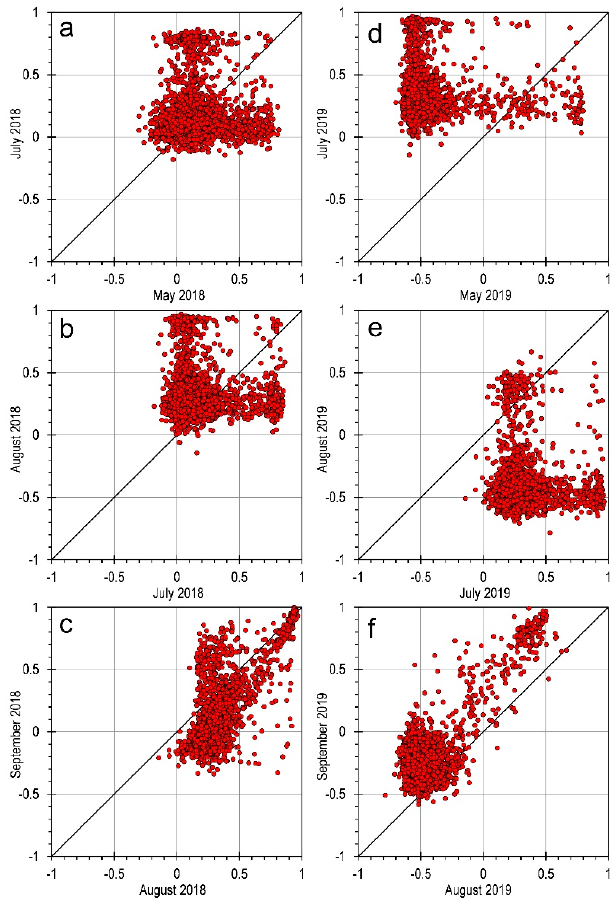
Figure 7. Intra-year (2018 ( a – c ); 2019 ( d – f )) comparison of the Modified Normalized Difference Water Index (MDNWI) for 2018 -2019.